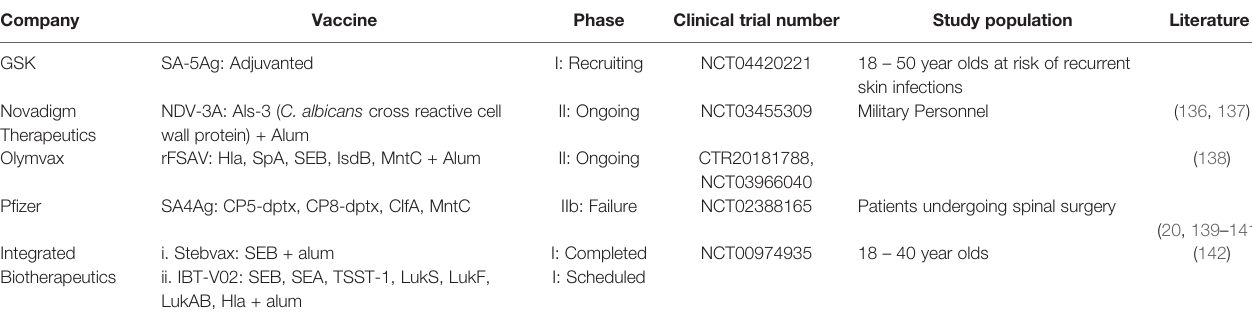
TABLE 1 | Staphylococcus aureus vaccines currently enrolled in clinical trials. Company